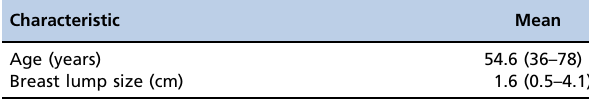
Table 1 - General characteristics of studied patients.